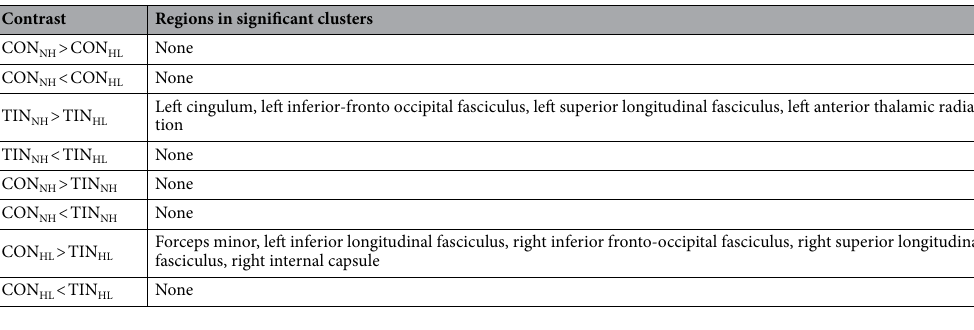
Table 2. Subgroup contrasts for which FA analysis was conducted. Regions included in clusters that showed group differences in the contrast are